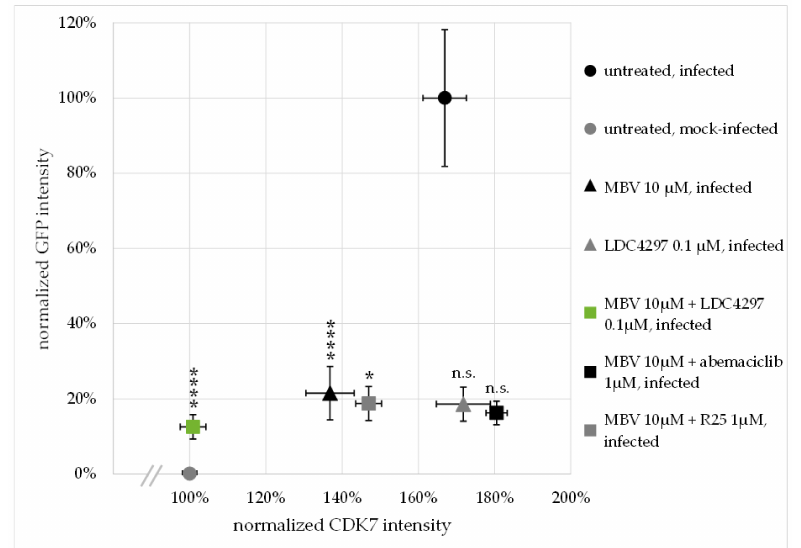
Figure 4. Quantitation of the CDK7 and GFP confocal immunofluorescence signals in HFFs treated with single PKIs, PKI combinations or solvent control (untreated). DAPI-corrected GFP signal was normalized with untreated, mock-infected cells as 0% and HCMV AD169-GFP-infected untreated cells as 100% ( y axis). DAPI-corrected CDK7 signal was normalized with untreated, mock-infected cells as 100%. For each treatment condition, >90 cells were analyzed; data are shown as mean ± SEM. Statistical analysis was performed using ordinary one-way ANOVA and post-hoc Tukey’s test on CDK7 intensity values only. The most relevant synergistic drug combination, MBV + LDC4297, is highlighted in green; **** p ≤ 0.0001; * p ≤ 0.05; n.s., not